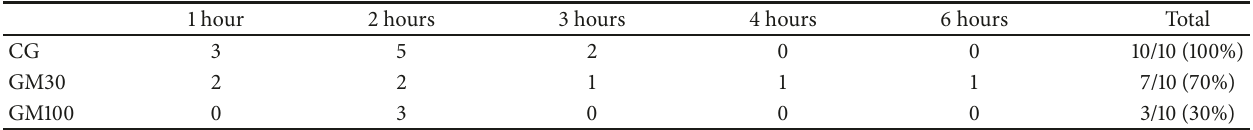
Table 3: Number of cats receiving rescue analgesic with the UNESP-Botucatu multidimensional composite pain scale (MCPS) over time following